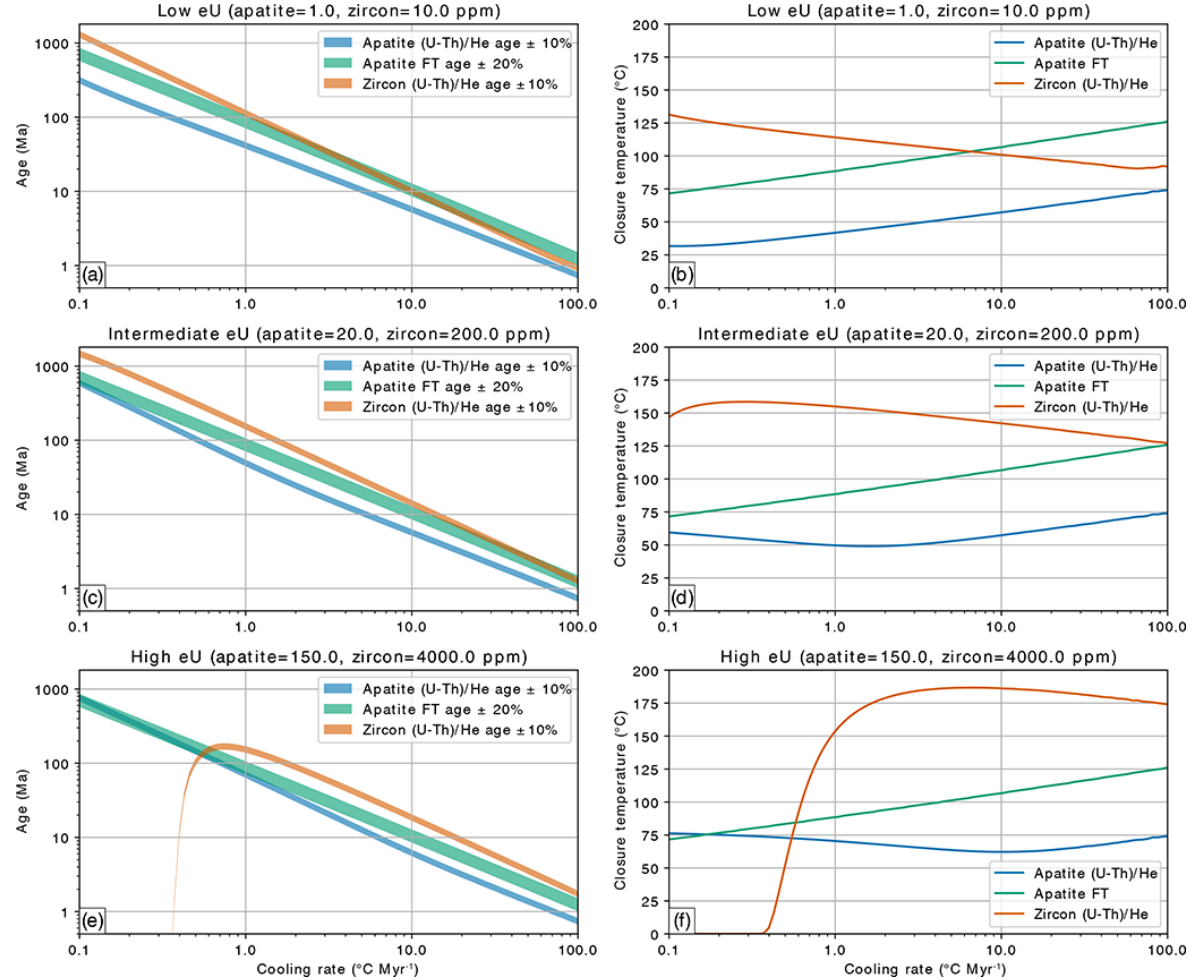
Figure 5. Predicted thermochronometer ages (a, c, e) and closure and annealing temperatures (b, d, f) for low (a, b) , intermediate (c, d) , and high (e, f) eU concentrations as a function of cooling rate. The plots comprise predicted ages and closure temperatures for 303 forward models, and each model applies a constant cooling rates between 0.1 and 100 ◦ CMyr − 1 . The colored swaths for the predicted ages (a, c, e) indicate the mean age plus or minus the indicated percentage of